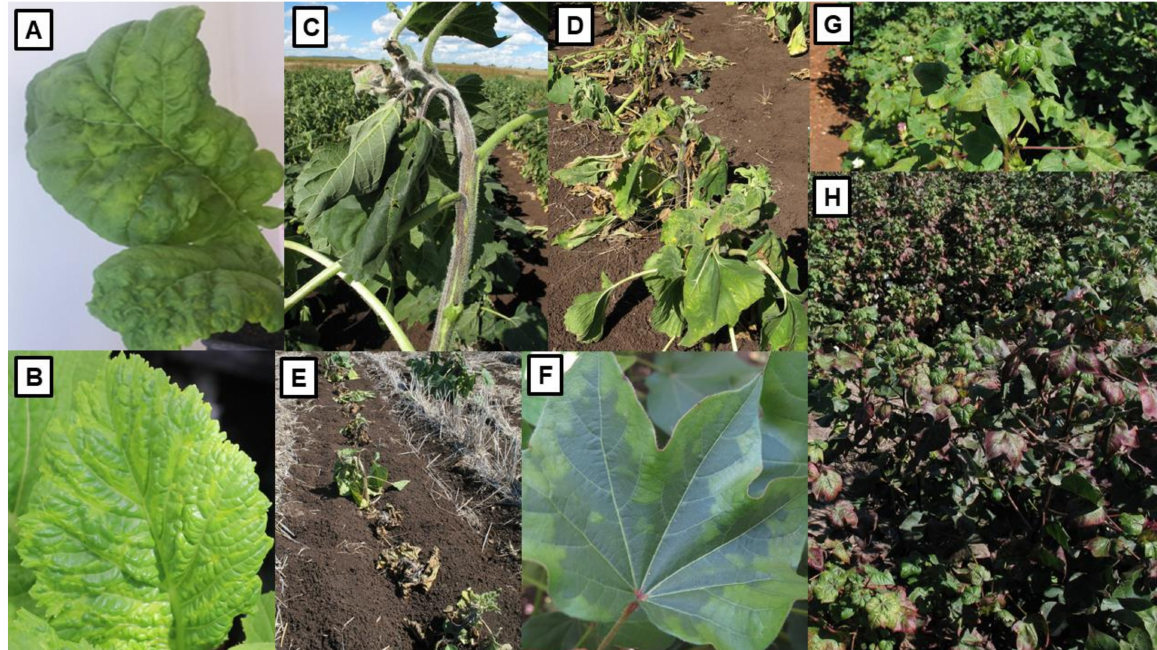
Figure 6. Symptoms of turnip mosaic virus (TuMV) in canola and Indian mustard, tobacco streak virus (TSV) in sunflower and cotton bunchy top virus (CBTV) in cotton in Australia. ( A ) TuMV-infected canola leaves with mosaic symptoms. ( B ) TuMV-infected Indian mustard leaf with mosaic symptoms. ( C ) TSV-infected sunflower plant with necrosis (black streaking) of the leaf lamina, petiole and stem, shortened internodes and a weakened stem. ( D ) Sunflower plants collapsing due TSV-infection. ( E ) Row of dead and dying sunflower plants caused by TSV-infection. ( F ) Leaf of CBTV-infected cotton showing pale light-green angular patterns along leaf margins. ( G ) Young shoot of a CBTV-infected cotton plant with leaf symptoms of downward cupping, marginal curling, deformation and reduction in size (in foreground). ( H ) CBTV-infected mature cotton crop showing reddening and downcurling of their leathery textured upper leaves. ( A , B ) image credit @University of Western Australia/E. Nyalugwe. Images ( A , B ) modified from [265] and [208],